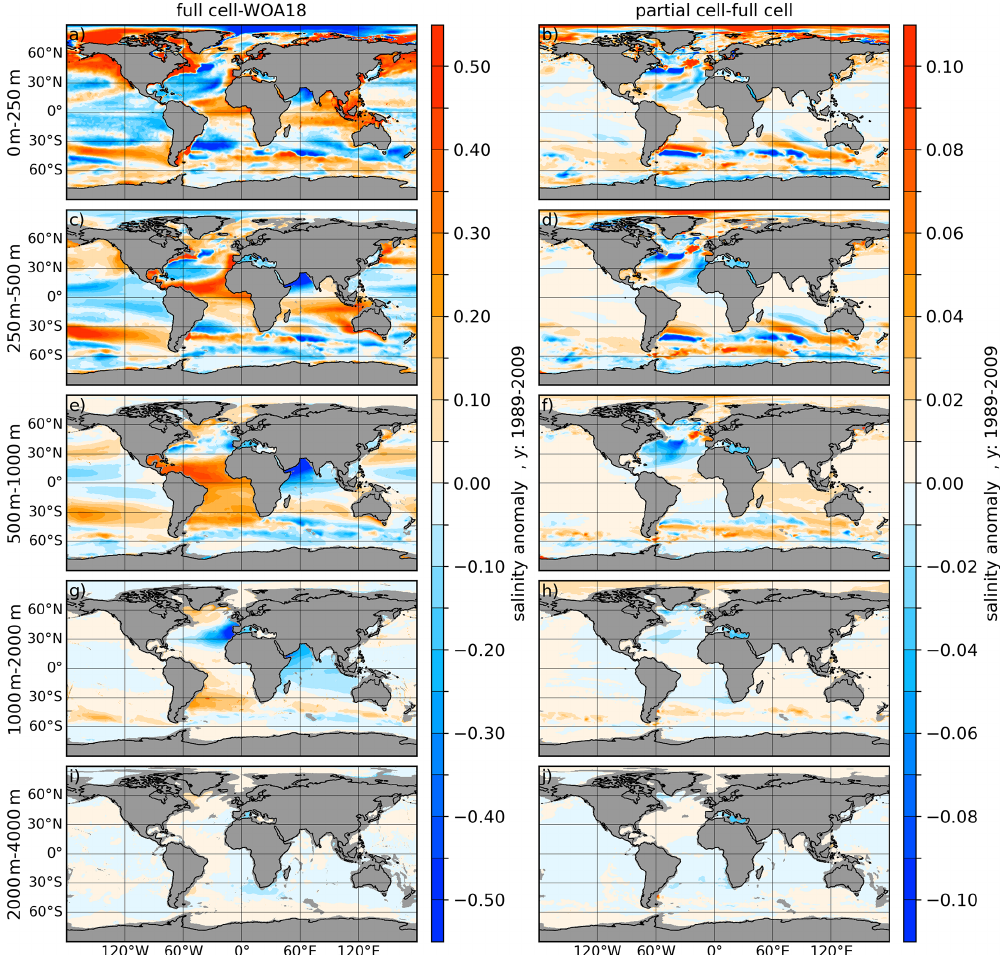
Figure 2. The same as Fig. 1 but for